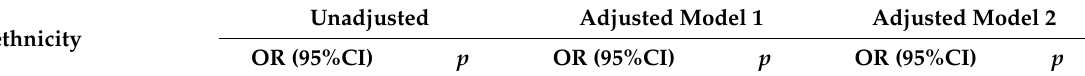
Table 1. Logistic regression analysis results for